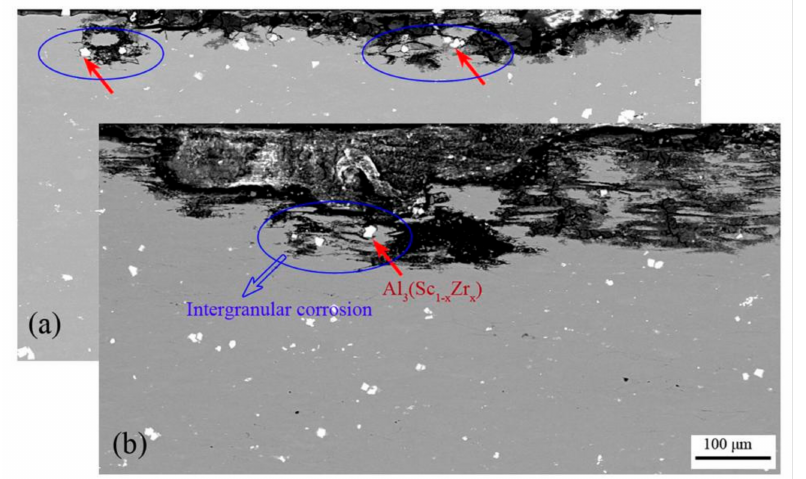
Figure 12. BSE images of the local corrosion regions around the primary Al 3 (Sc 1 − x Zr x ) phase particles. ( a ) Al-Zn-Mg-Cu-Sc-Zr alloy in the central layer, ( b ) Al-Zn-Mg-Cu-Sc-Zr alloy in the surface